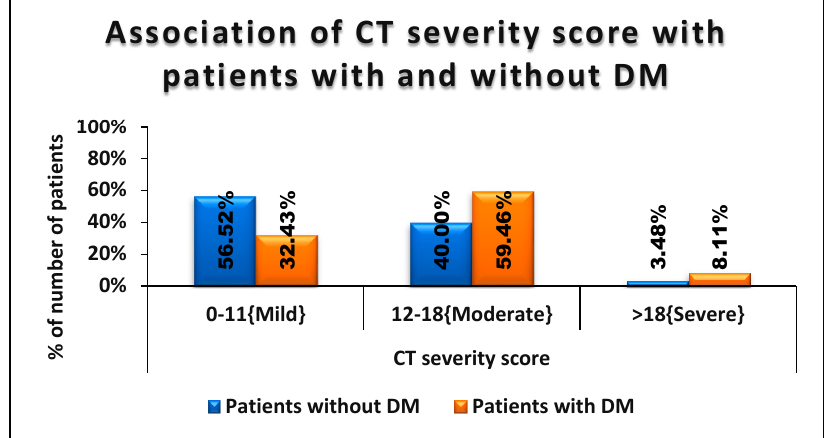
Figure 2. Association of CT severity score with patients with and without DM.